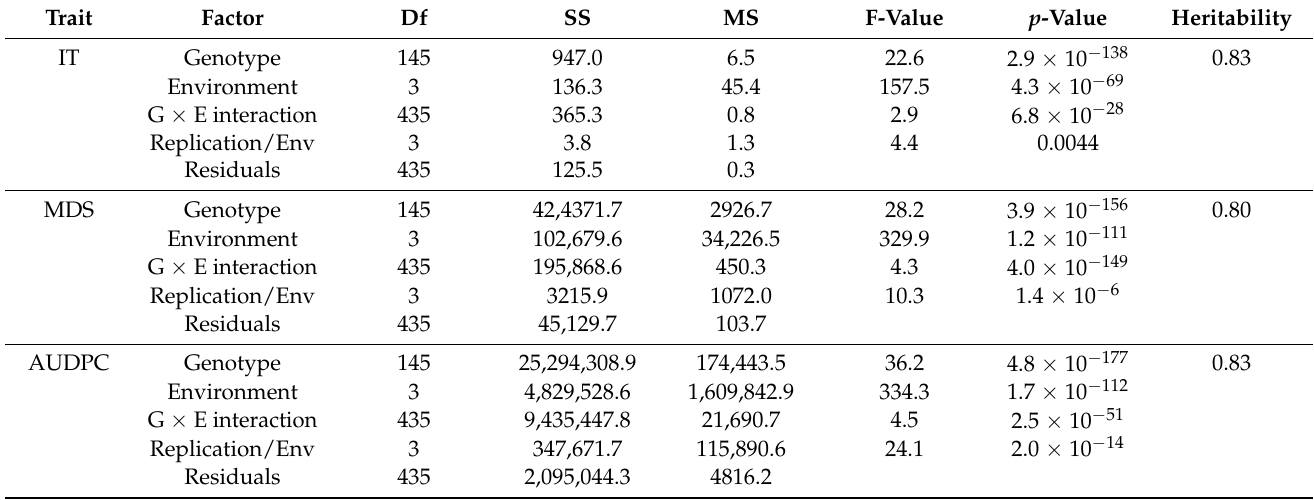
Table 1. Analysis of variance of the three stripe-rust-resistance traits evaluated at the adult-stage under four environments.